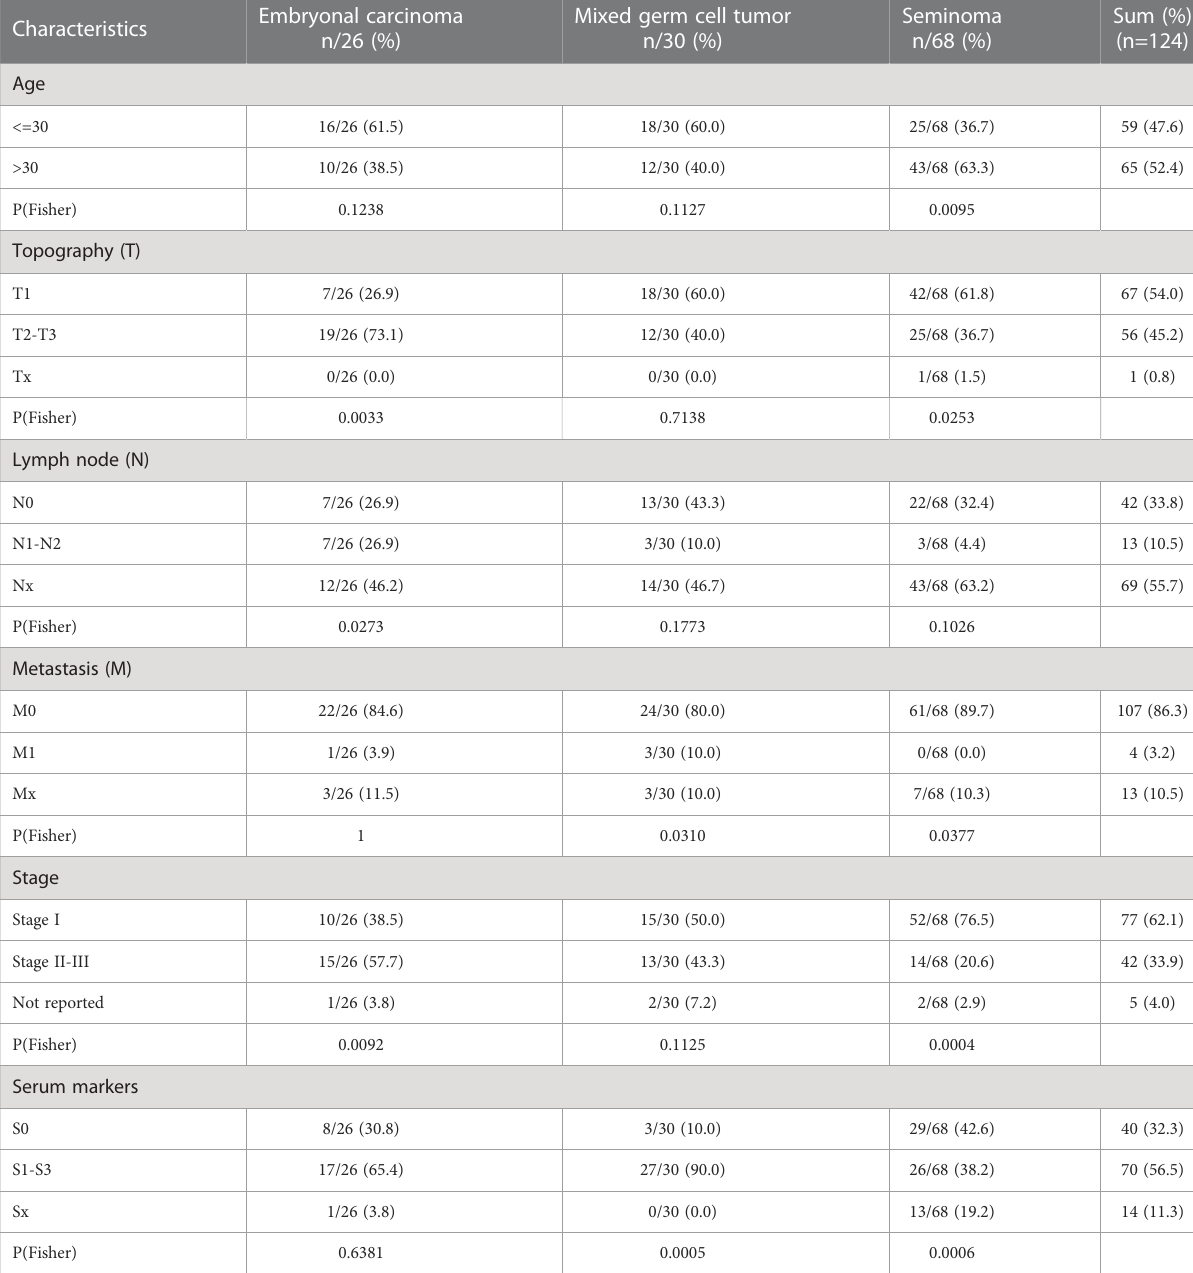
TABLE 1 Characteristics of subtypes with TGCT based on